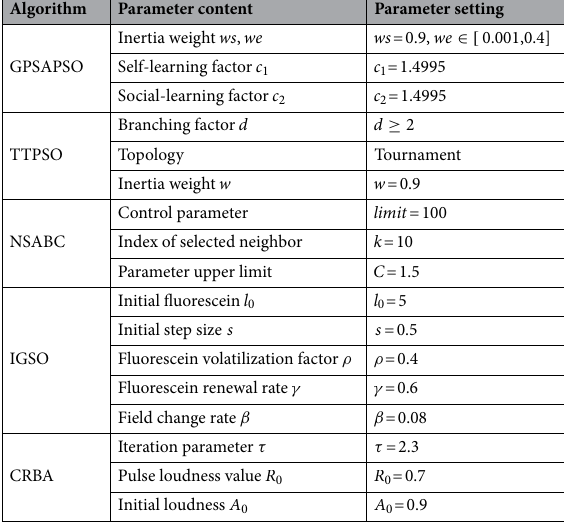
Table 2. Parameter setting.